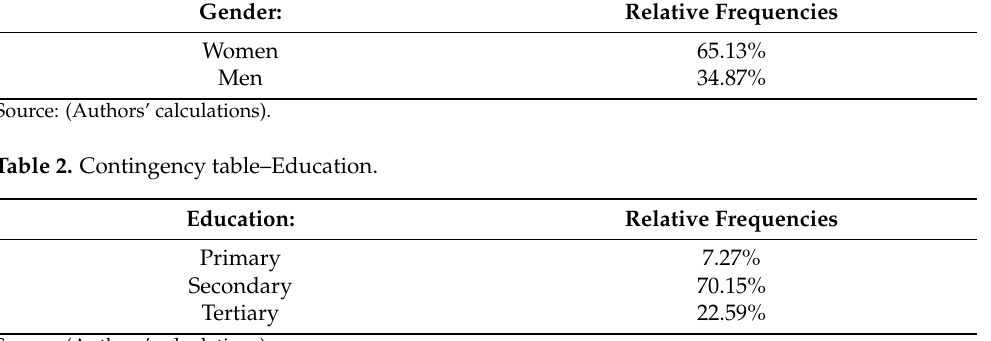
Table 1. Contingency table–Gender. Gender: Relative Frequencies Women 65.13% Men 34.87%